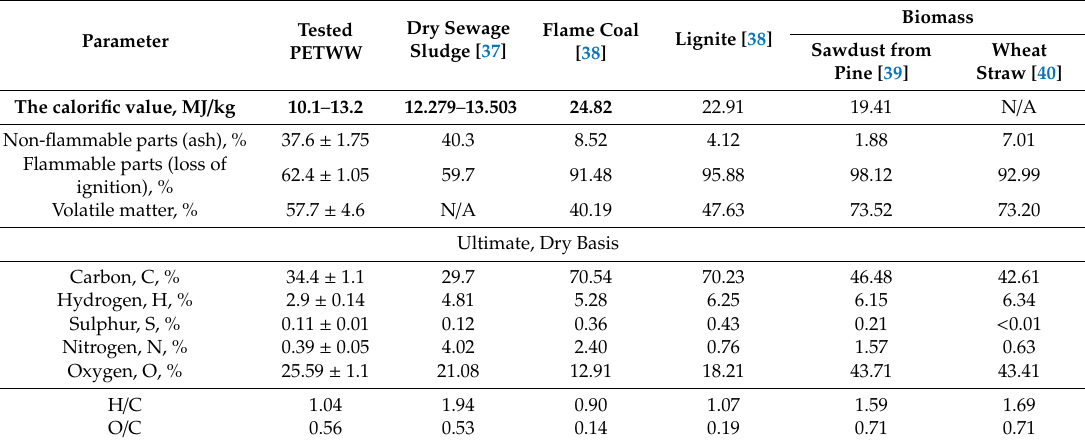
Table 3. Fuel properties of PETWW in comparison with other solid fuels and recommended values for formed